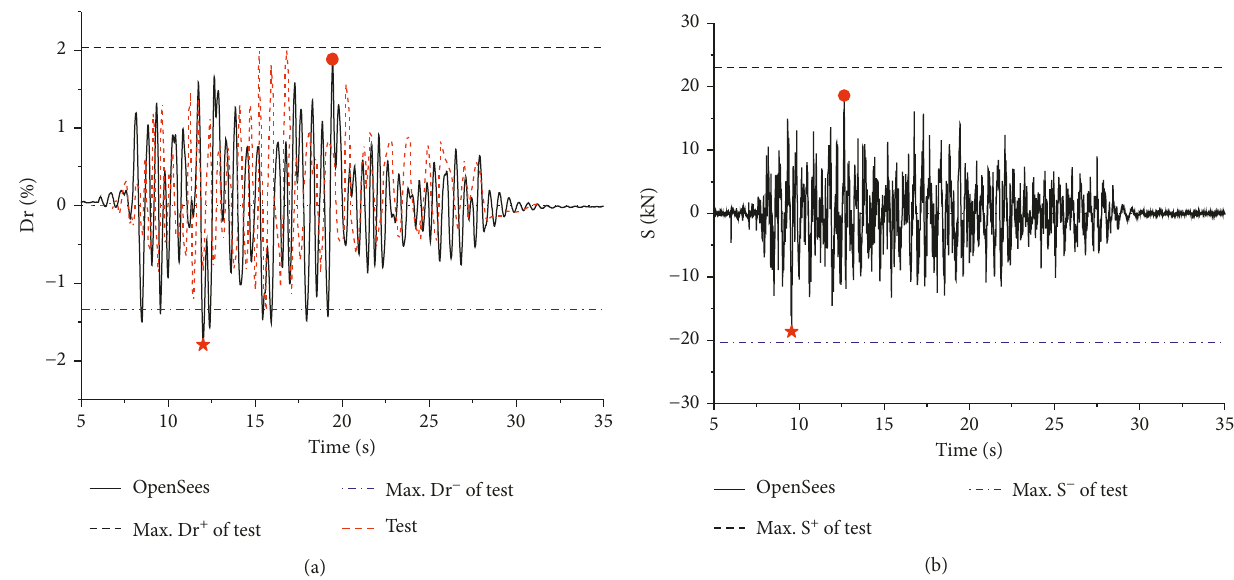
Figure 8: Comparison of analytic model and test for specimen ST 1-d. (a) Drift ratio. (b) Strength.